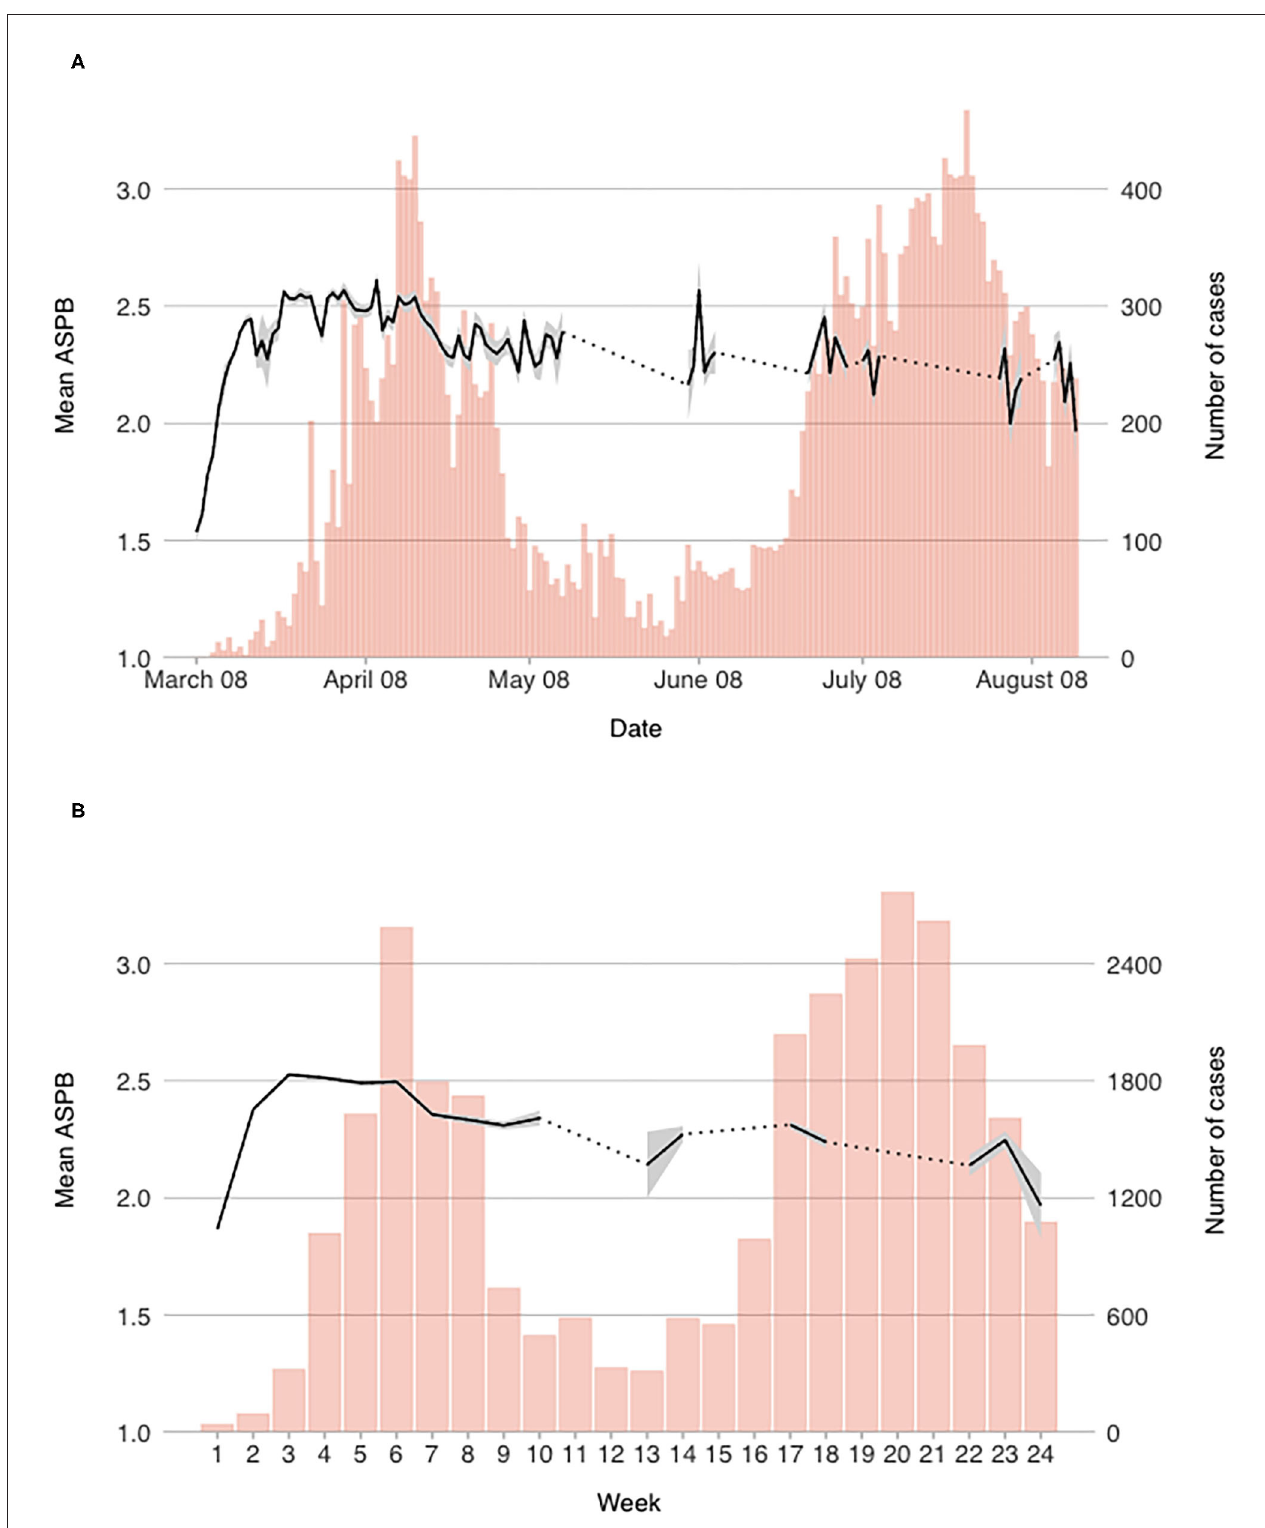
FIGURE 3 | Mean reported engagement in actual self-protective behavior on a (A) daily, and (B) weekly level.